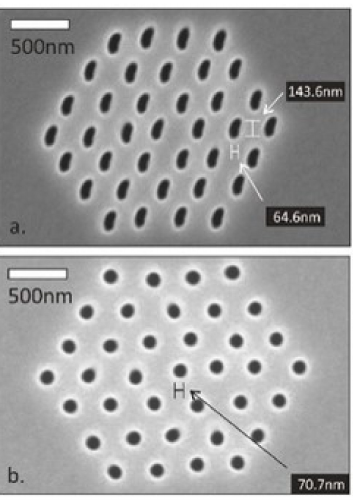
Figure 5. Focused ion beam lithography.